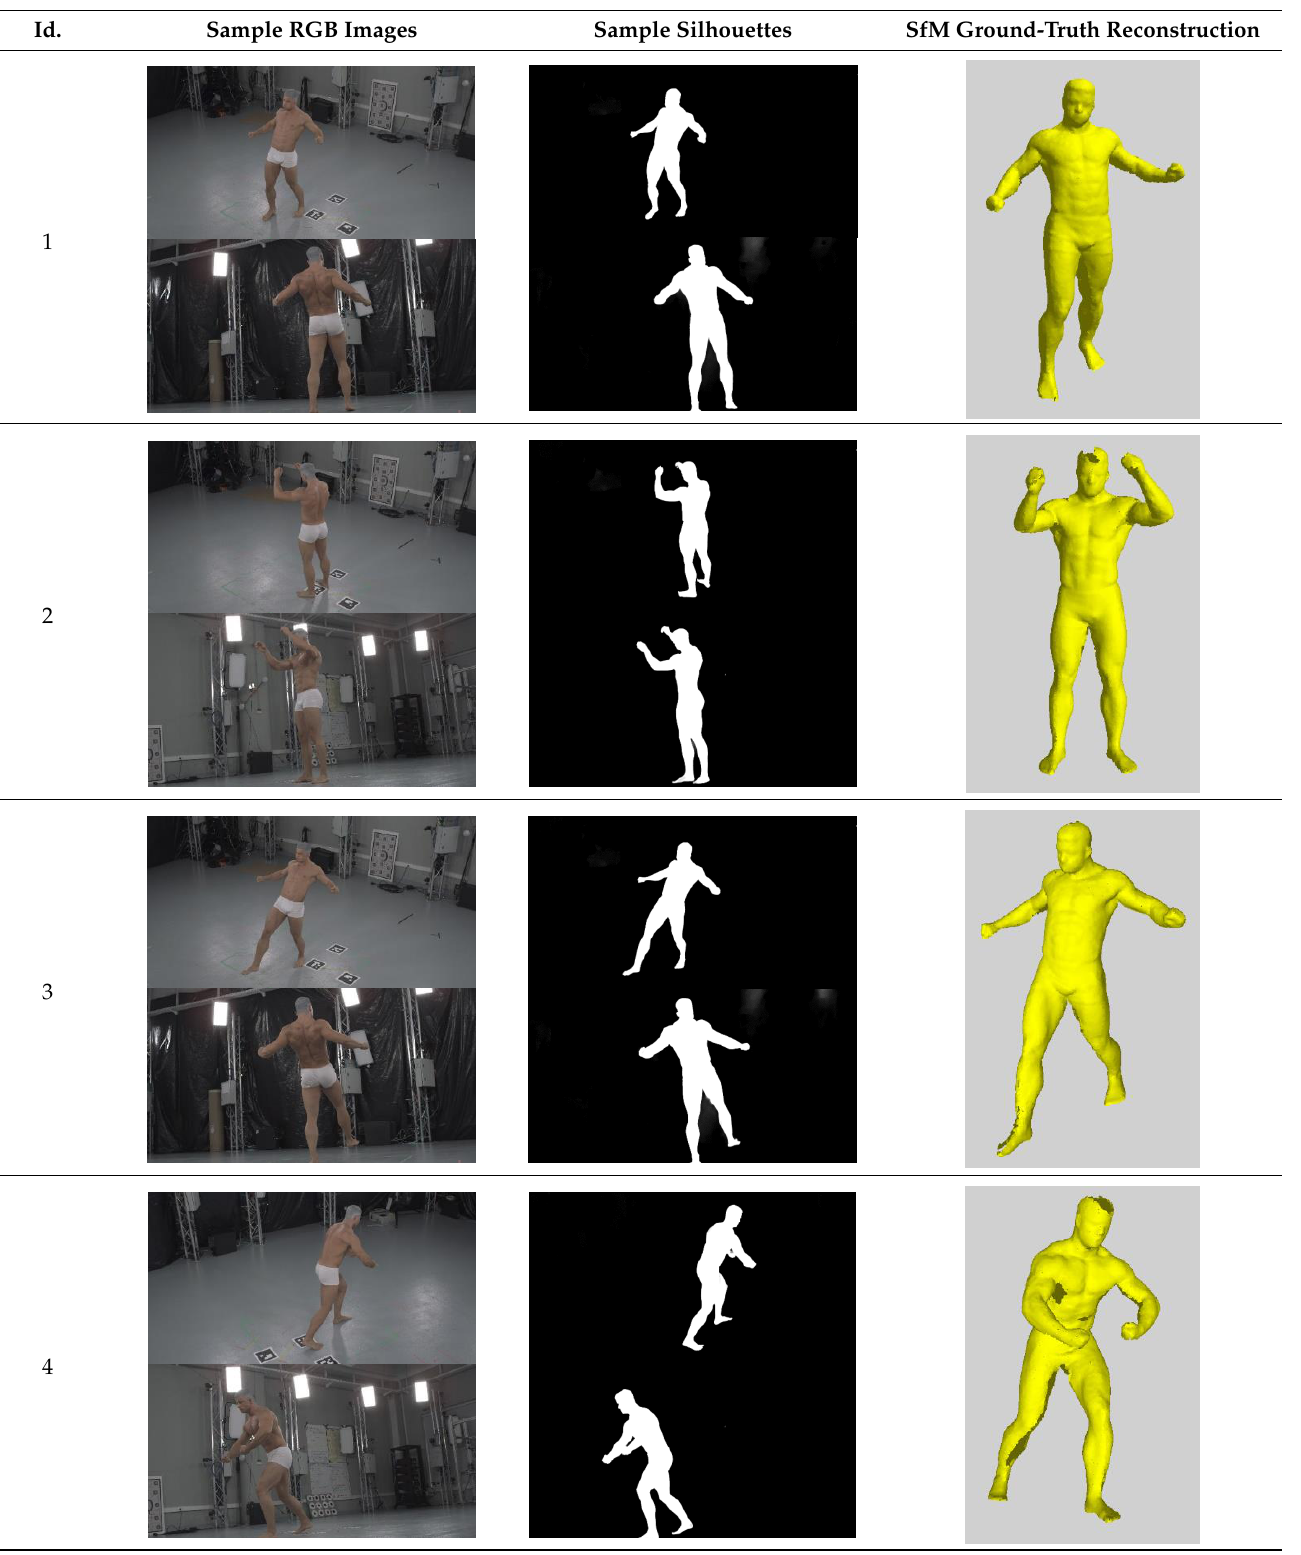
Table A1. Sample RGB images with estimated silhouettes for 34 cameras and SfM reconstructions used to validate the SfS/sSfS reconstruction. The dataset contains image sets and 3D scans of 20